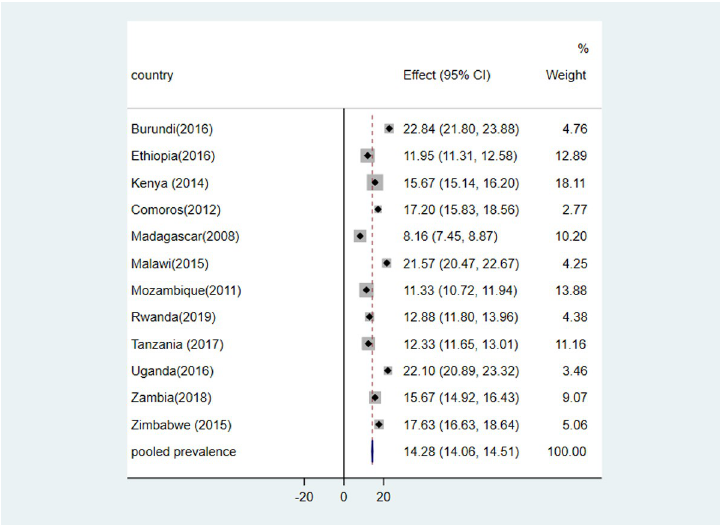
Fig 1. Forest plot of the pooled prevalence of diarrhea among under five years of children in Eastern African countries.